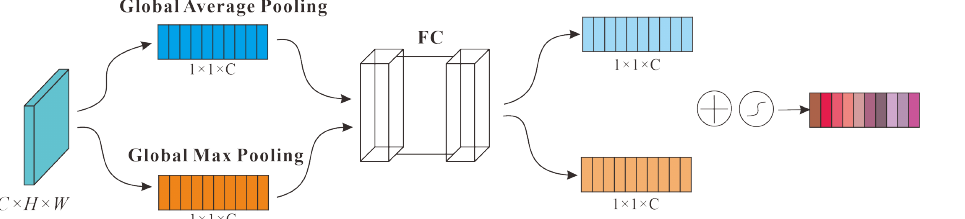
Figure 5. The Soft Attention Mechanism, H × W × C is the features map ( P ), the blue block represents global average pooling, the orange block represents global maximum pooling, and the colored block represents the feature weight